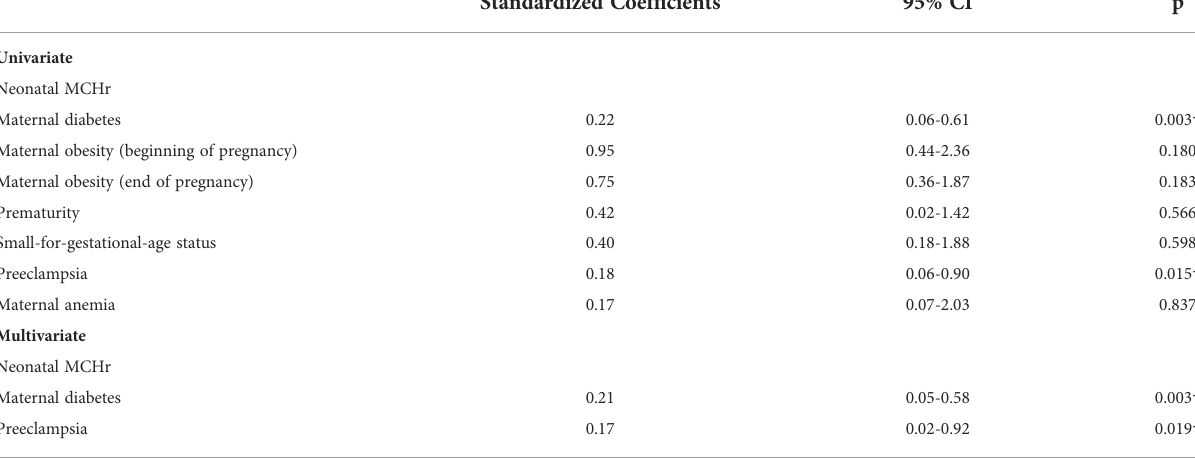
TABLE 3 Linear regression analysis (univariate and multivariate) of the association of neonatal MCHr with categorical factors of interest.